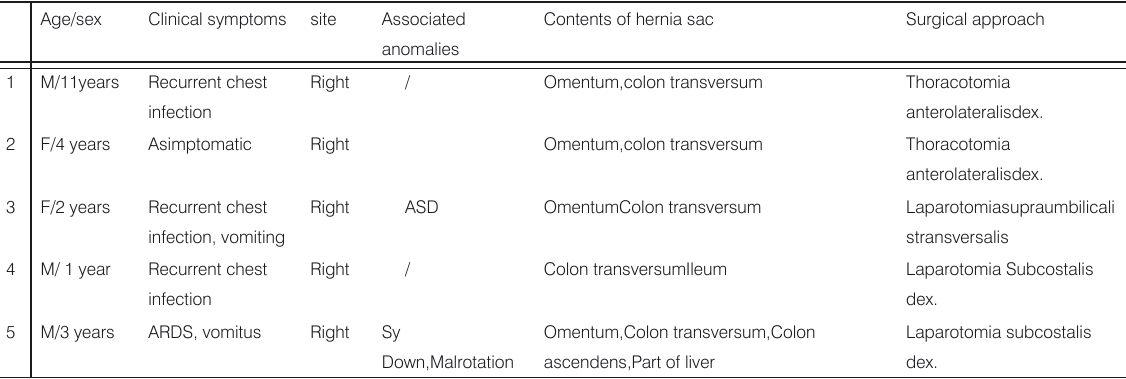
Table 2. Presentation of CMH by sex, age, site, signs, associated anomalies and surgical